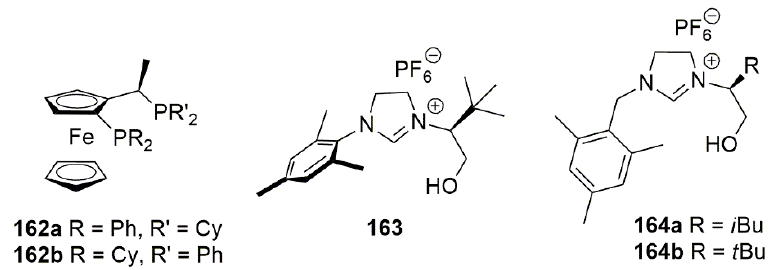
Molecules 2022 , 27 , x FOR PEER REVIEW